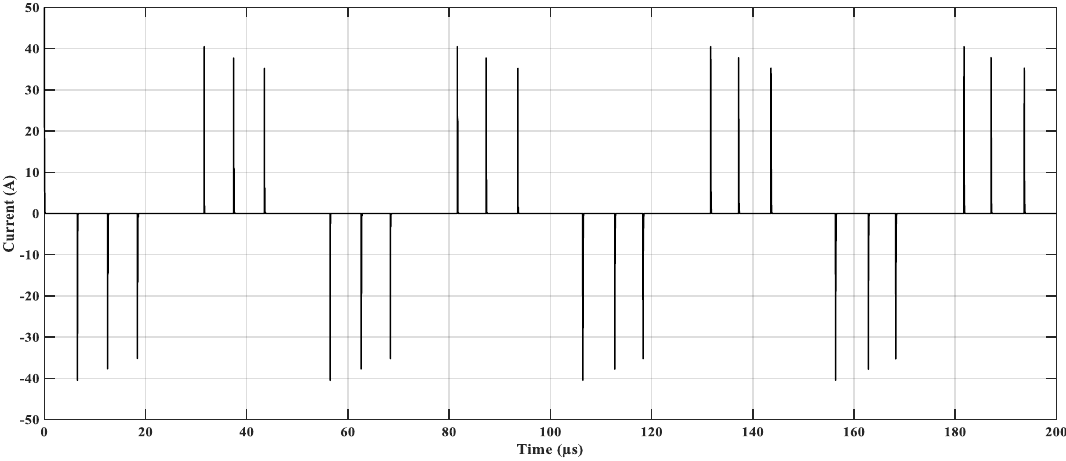
Figure 9. Common-mode current without the ACMVC.